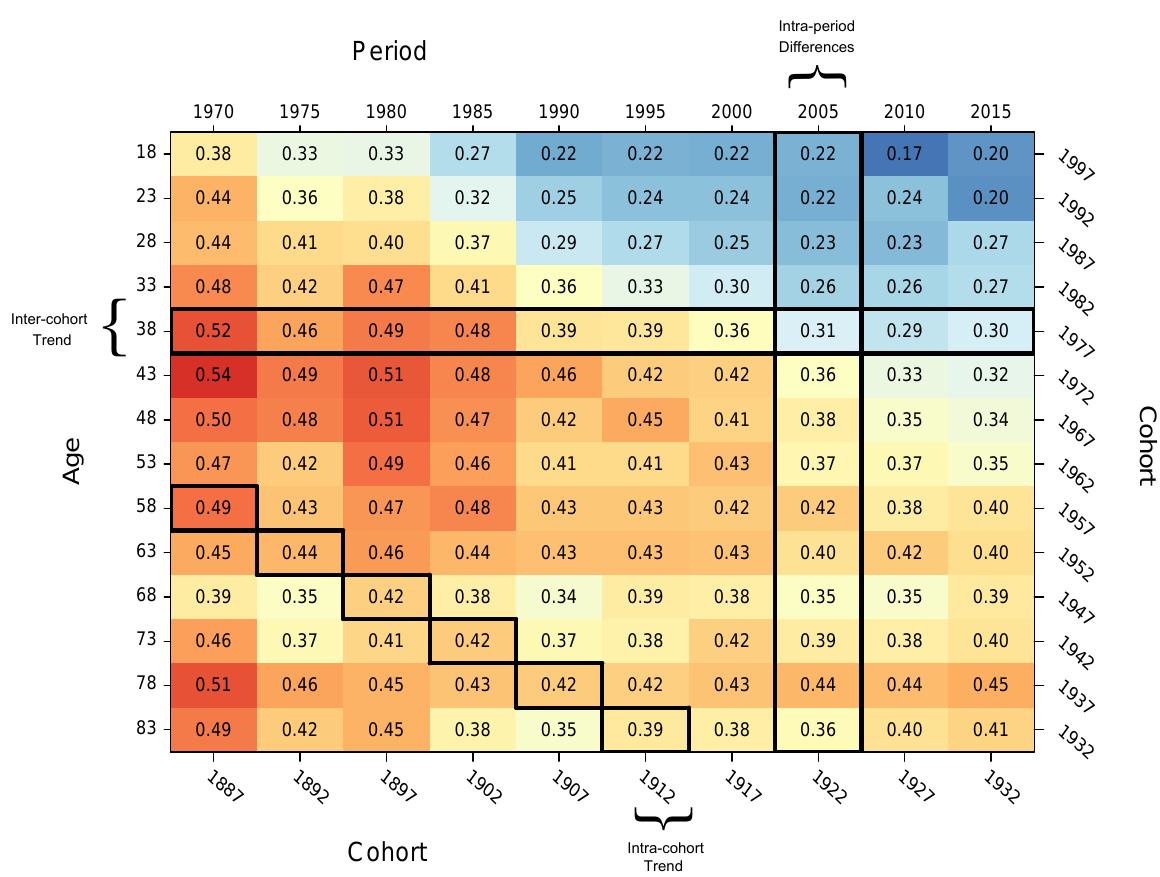
Figure 3: Two-dimensional Lexis heat map of diachronic trends and synchronic differences, plotting predicted probabilities from a diachronic L-APC logistic regression model. Notes: Outcome is social trust, coded so that 1 = “can trust” while 0 = “can’t be too careful” or “depends.” Sample size R = 41, 126 respondents. Results adjusted using sampling weights. Three sections are highlighted: the diachronic intra-cohort trend for the 1912-to-1916 birth cohort (diagonal section), the diachronic inter-cohort trend for the 38-to-42 age group (horizontal section), and intra-period differences for the 2005-to-2009 period group (vertical